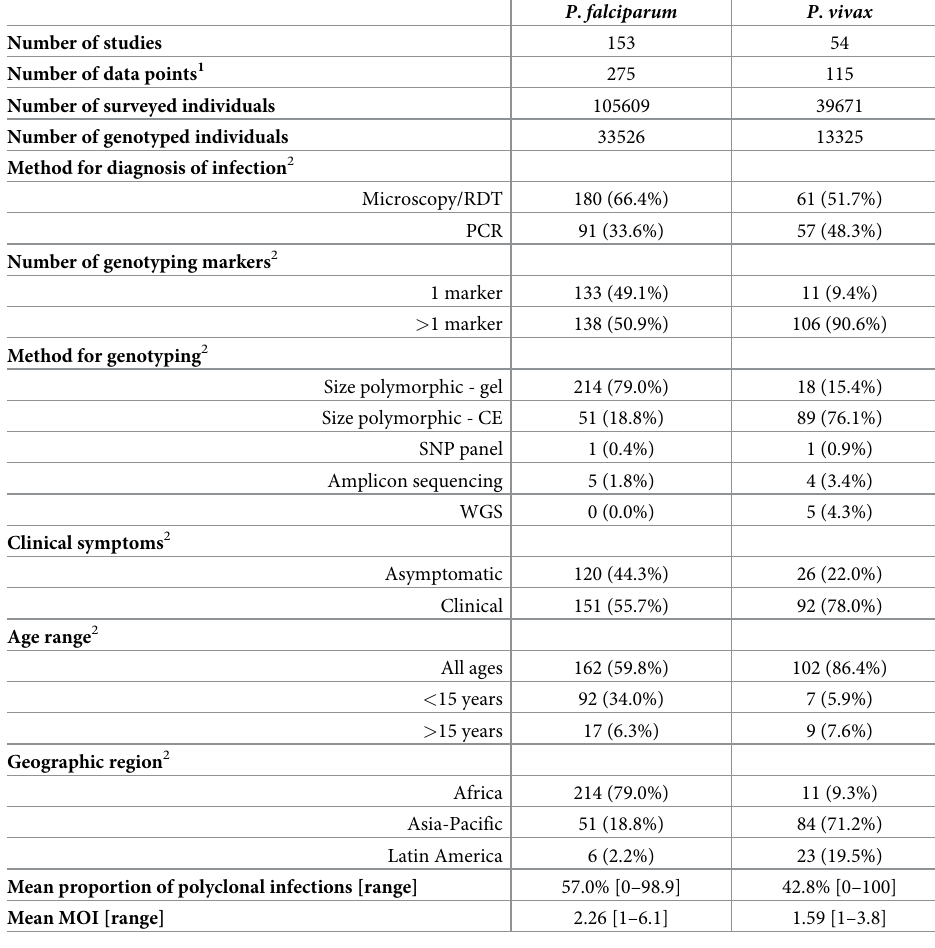
Table 1: Characteristics of studies analyzed. 1 Multiple data points were retrieved from a study if data was reported separately for different locations, age groups, time points, or separately for clinical and asymptomatic individuals. 2 For each factor, the number and percentage of data points is